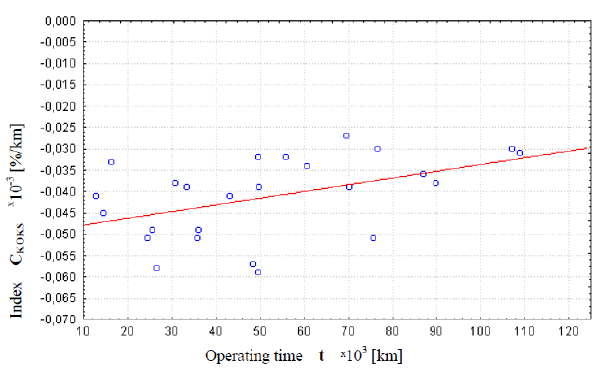
Fig. 5. Power regression model of the C V100 index in relation to the vehicle